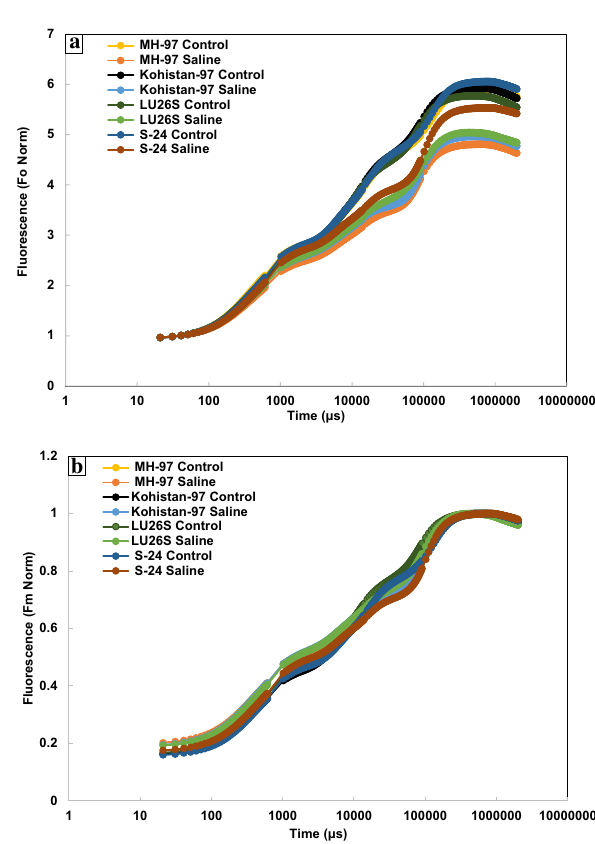
Figure 6. Normalized OJIP chlorophyll a fluorescence transients of ( a ) Fo and ( b ) Fm for four wheat cultivars subjected to 0 or 150 mM NaCl stress at vegetative